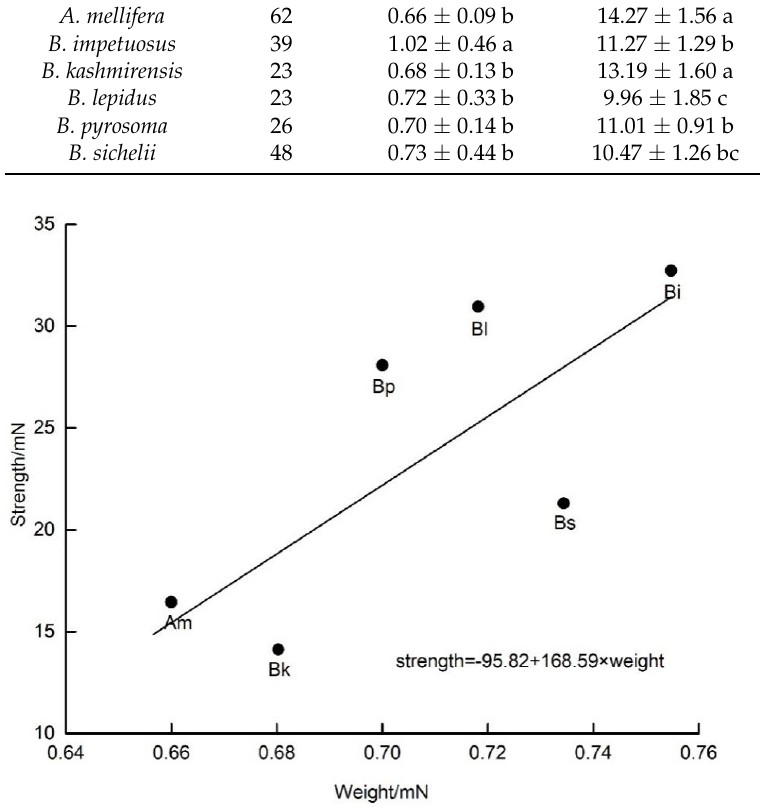
Figure 6. Linear regression with visitors’ weight as an independent variable and strength as a dependent variable. p = 0.022; r 2 = 0.613. Am, A. mellifera . Bi, B. impetuosus . Bk, B. kashmirensis . Bl, B. lepidus . Bp, B. pyrosoma . Bs, B. sichelii .